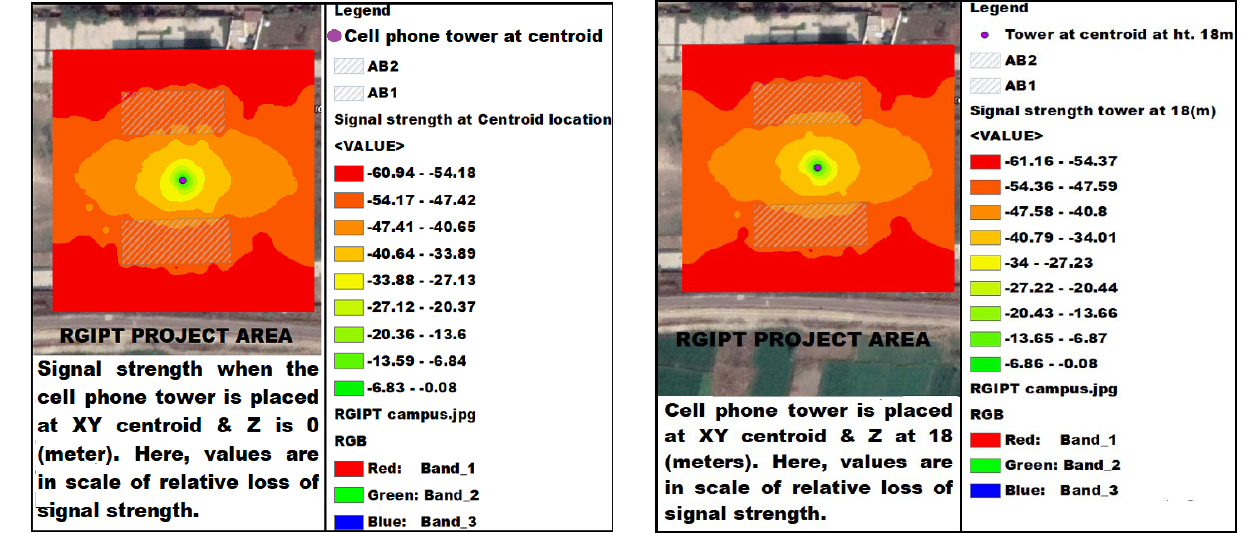
Figure 15. Cell phone tower at XY Centroid and Z at 0 meters .